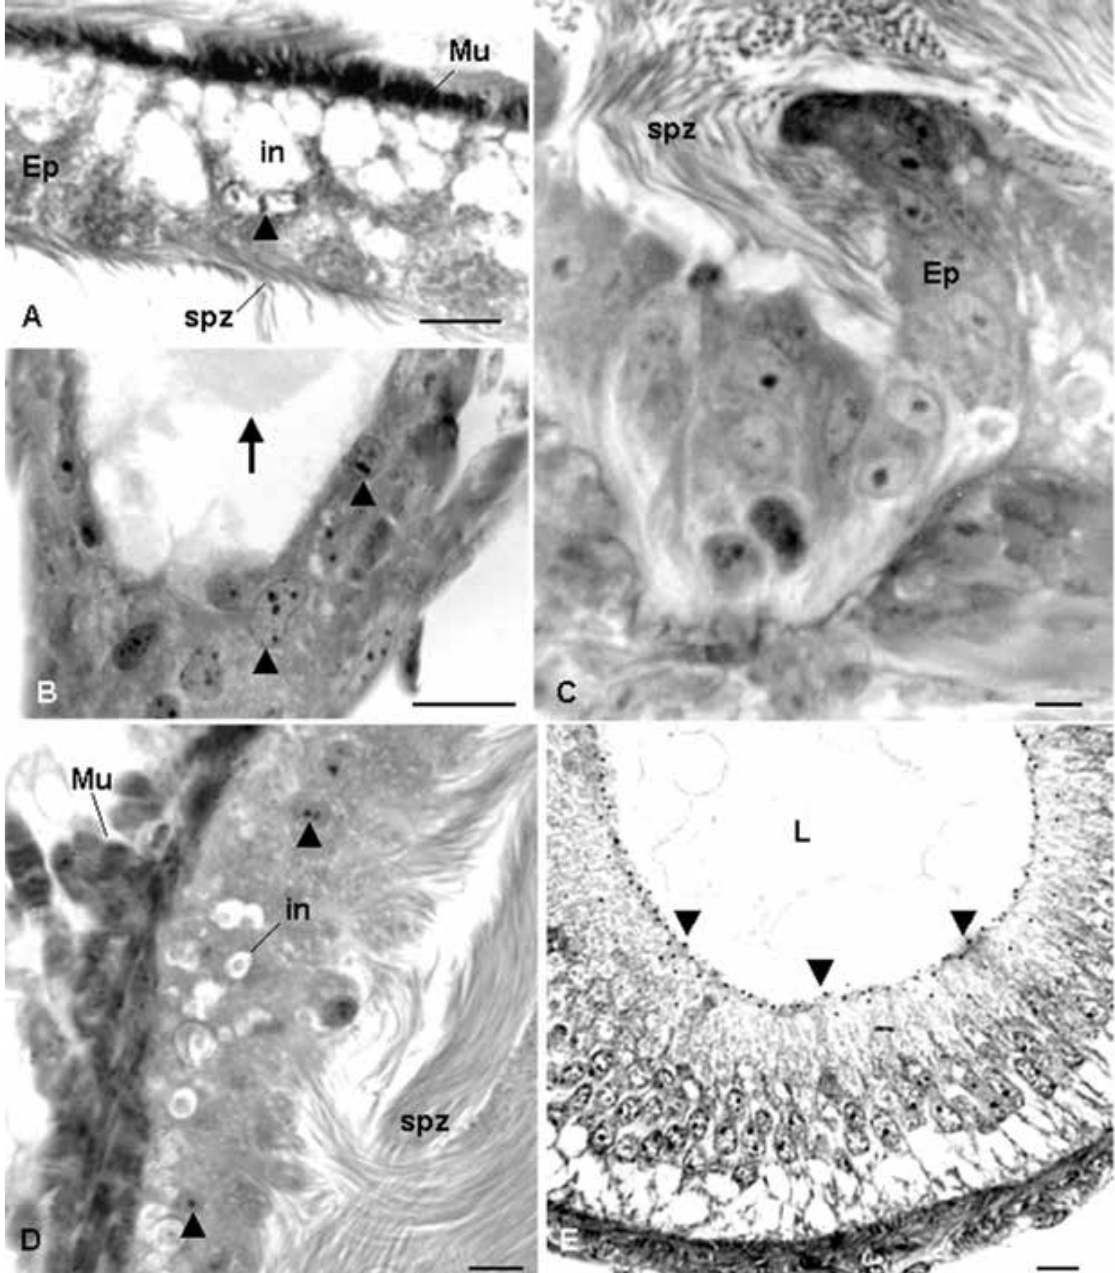
Fig 4 . Light micrographs of transverse sections of the seminal vesicles and post-vesicular vasa deferentia of Scaptotrigona xanthotricha . A. Seminal vesicle in 10-day-old male showing sperm (spz) in the lumen, muscular cells lining externally (Mu), and the cubic epithelium (Ep) with cell nuclei (arrowhead) associated with vesicle-like inclusions (in). B-D. 22-day-old males showing (B) vas deferens secretion (arrow) in the lumen and nuclei with some clumps of condensed chromatin (arrowhead); (C) spermatozoa (spz) associated with deep epithelial fold (ep); and (D) basal region of the epithelium with many vesicle-like inclusions (in) and the nuclei with clumps of condensed chromatin (arrowhead). E- Representative epithelium of seminal vesicle in black-eyed pupae showing PAS-positive reaction (arrowheads). Bars: A and D = 20µm; B = 30µm; C and E =